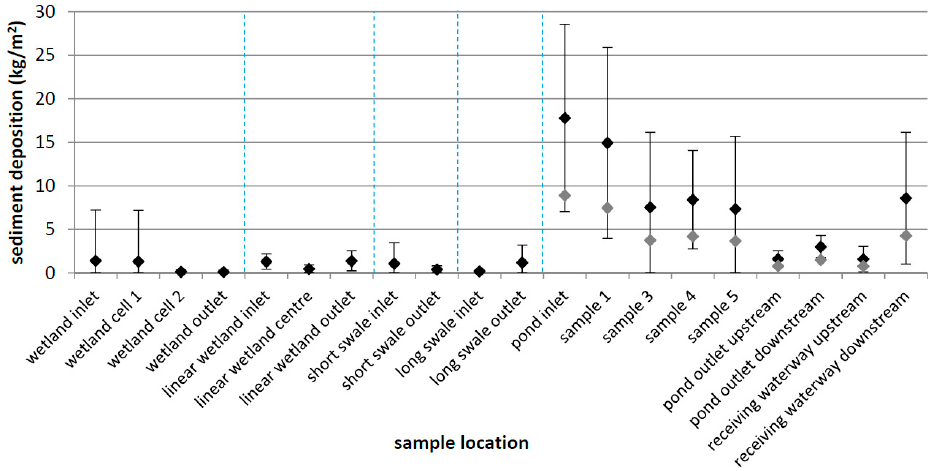
Figure 3. Deposited sediment within the investigated SuDS assets.